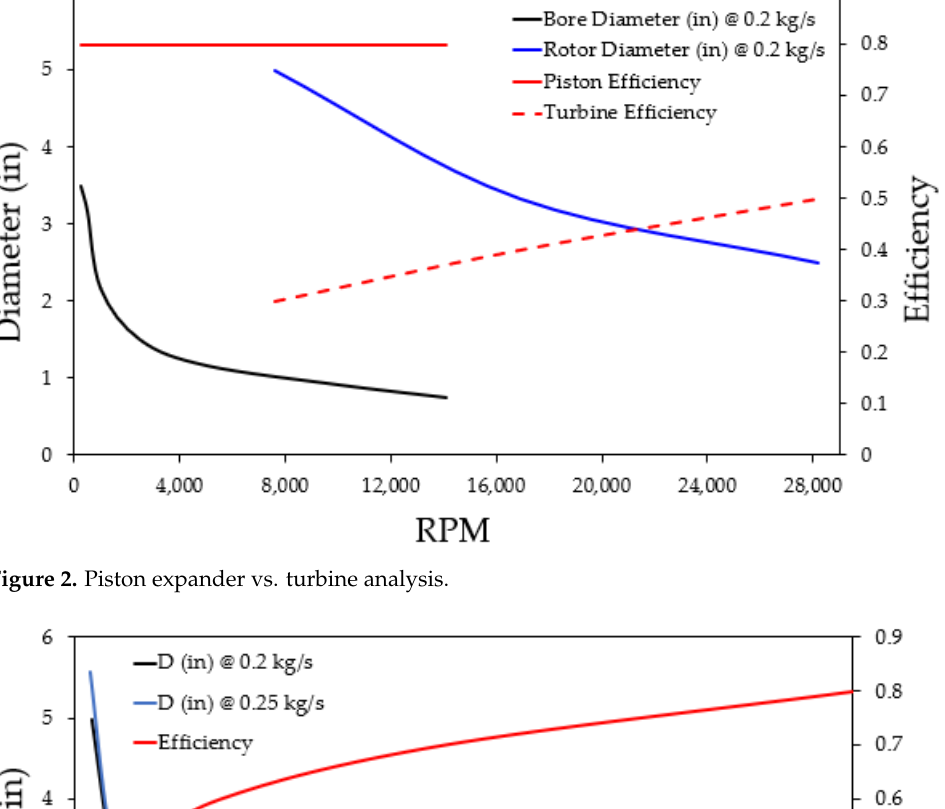
Figure 2. Piston expander vs. turbine analysis.